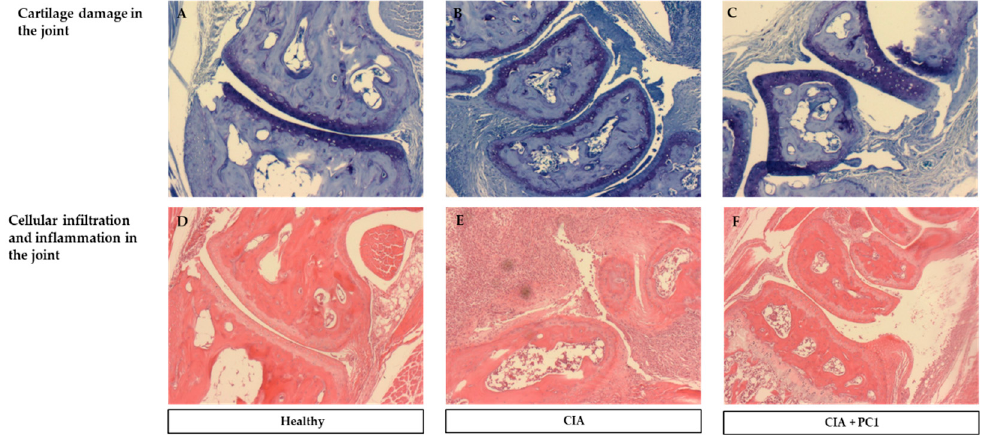
Figure 2. Representative histological staining with toluidine blue ( × 20) of paw joints of mice with collagen induced arthritis (CIA). ( A ) Healthy control mice show thick staining of the cartilage demonstrating lack of cartilage damage. ( B ) CIA mice have significantly less staining demonstrating breakdown of cartilage. ( C ) CIA mice given PC1 have less staining than the healthy mice but more than CIA mice indicating less cartilage damage. Hematoxylin and eosin staining of ( D ) healthy mice demonstrated no cellular infiltration. ( E ) CIA mice had massive cellular infiltration. ( F ) CIA mice given PC1 exhibited significantly less cellular infiltration than the CIA